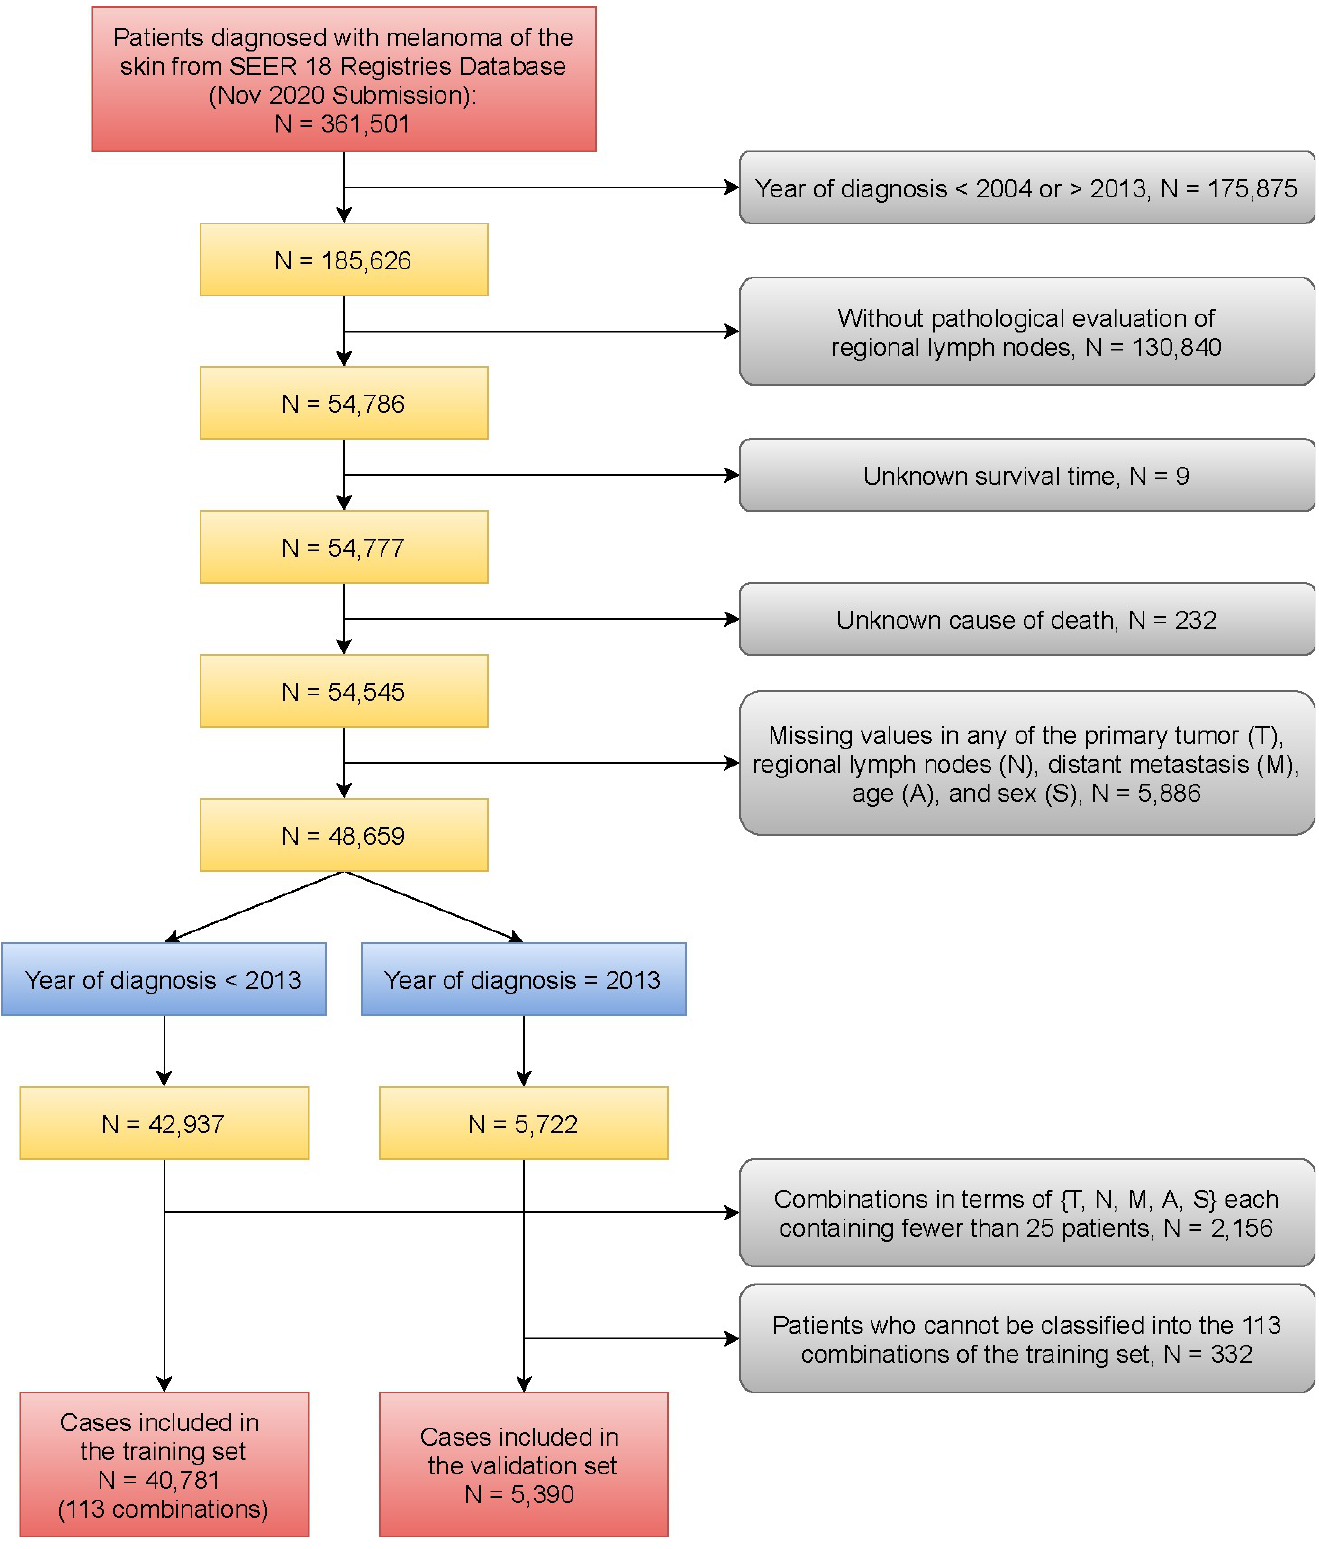
Fig 1. Flow diagram for selecting patients with skin melanoma.